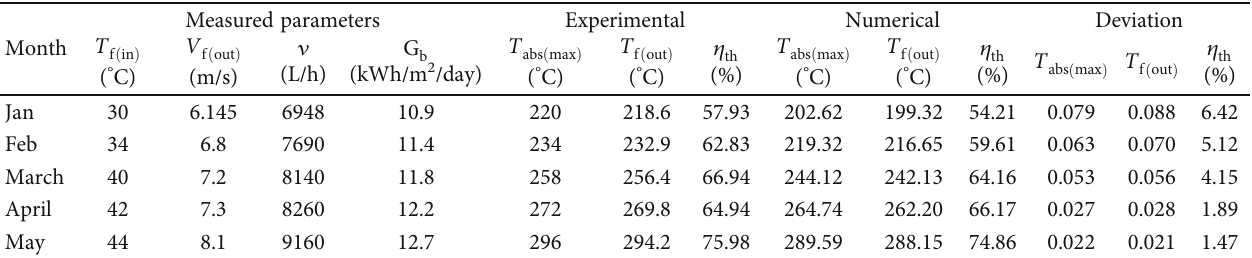
Figure 14: HTWF circulation layout along with water pumping mechanism. Table 4: Output obtained from SPDC system using modi fi ed